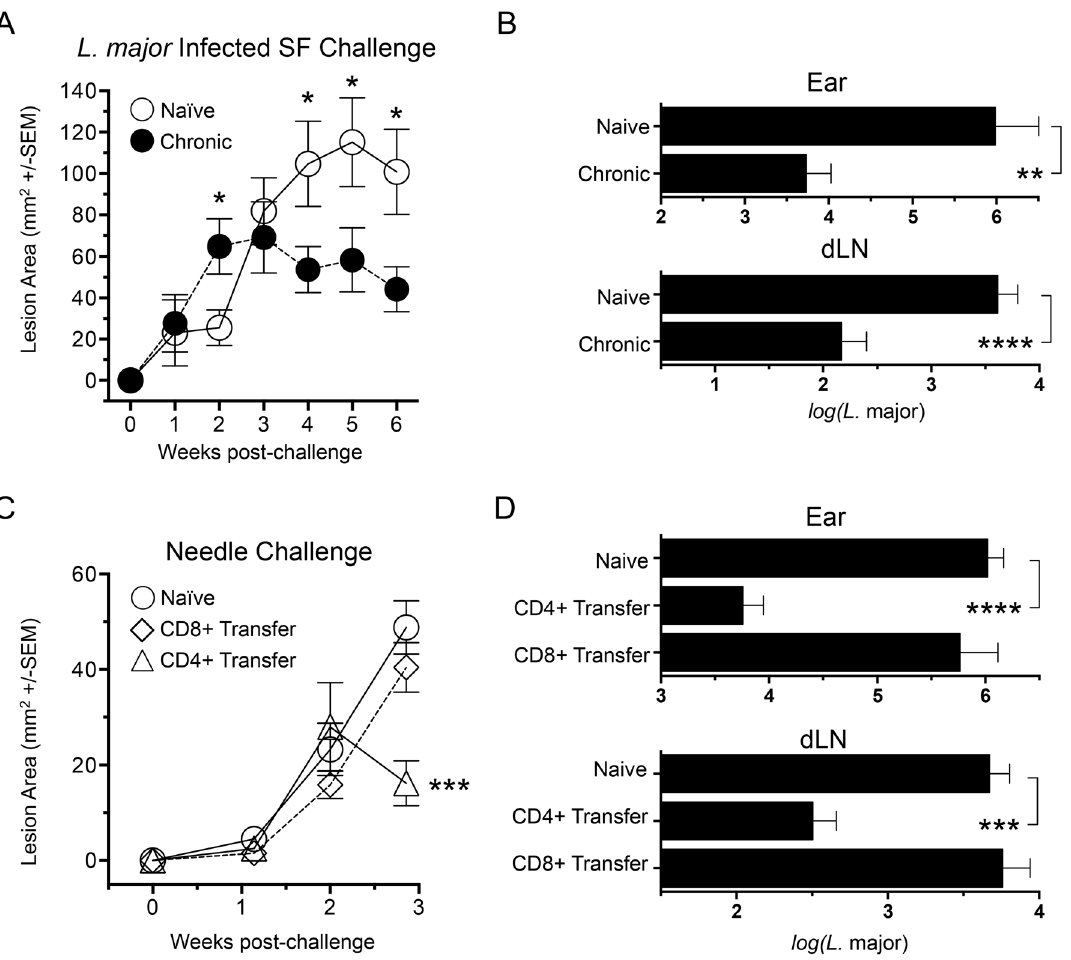
Figure 1. Chronic primary L.major infection protects against cutaneous Leishmaniasis initiated by infected sand fly challenge; CD4 + Th cells transfer protection. ( A and B ) Ears of naı¨ve, age matched control mice (Naı¨ve), or mice with a healed but chronic primary infection (Chronic) were exposed to the bites of 6 L. major -infected P. duboscqi sand flies ( L.m. Infected SF Challenge, n=12–16 ears per group). ( C and D ) Polyclonal TCR b + CD4 + CD8 2 CD11b 2 NK1.1 2 MHCII 2 (CD4 + ) or TCR b + CD4 2 CD8 + CD11b 2 NK1.1 2 MHCII 2 (CD8 + ) T cells were FACS sorted from 15 chronic mice and independently transferred into 3 wild type naı¨ve recipient mice at their pre-transfer physiological ratios (approximately 1 6 10 7 CD4 cells or 8 6 10 6 CD8 T cells). One day following transfer, ears were challenged with 5000 L. major metacyclic promastigotes, a dose meant to approximate the number of parasites transmitted by 6 L. major -infected P. duboscqi sand flies (Naı¨ve control group n=8, Transfer groups n=6 ears per group). ( A and C ) Ear lesions were measured weekly in two dimensions and the lesion area determined. In A: (*) p , 0.05, Naı¨ve versus chronic; in B: (***) p=0.0007 versus Naive. ( B and D ) Parasite loads in individual ears or dLNs at six (B) or three (D) weeks post-challenge. (**) p=0.0011, (***) p=0.0003, (****) p ,